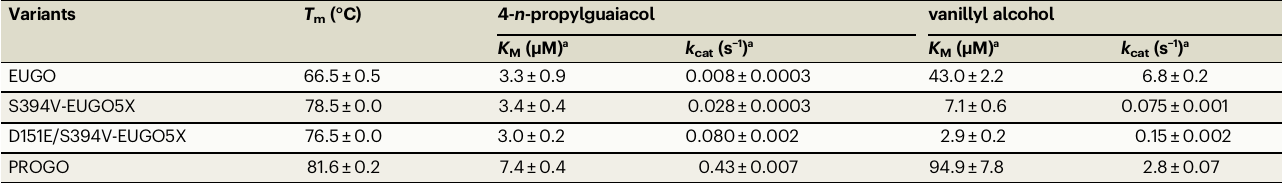
Table 1 | Thermostability and kinetic properties of wild-type EUGO and mutants Variants T m